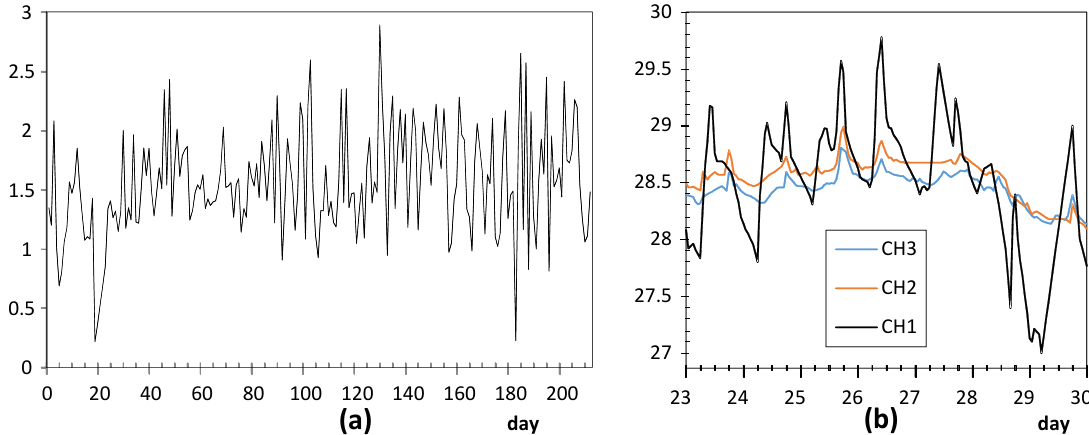
Figure 7. Node CH1: ( a ) time series of daily ranges of temperature ( ° C) for the whole period of 212 days; ( b ) time series of hourly values of temperature ( ° C) for the three nodes at the chapel, from day 23 (24 August 2017) until day 29. Node UP4 : ADR = 0.71 ° C. Figure 8a shows a clear shift in the time series of daily